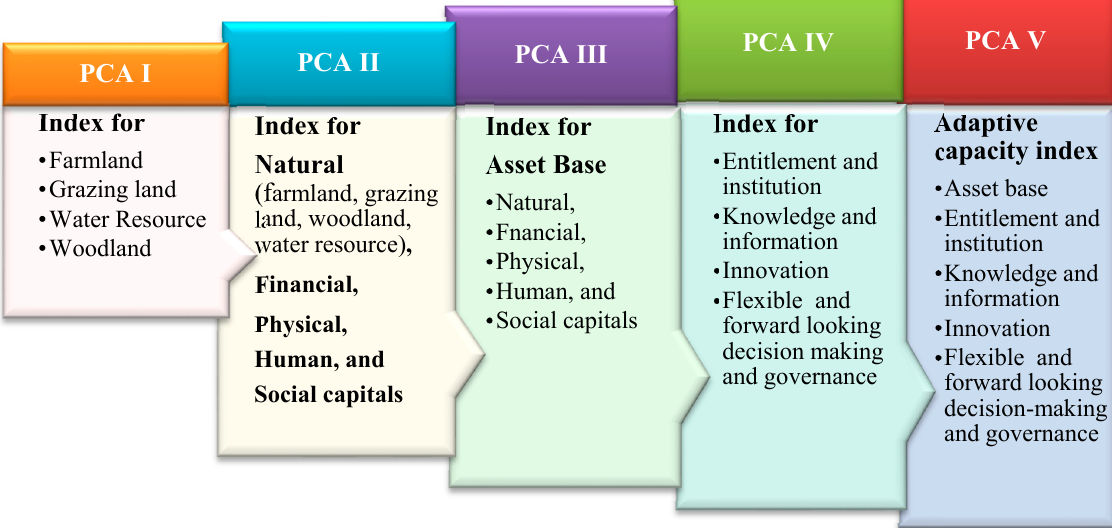
Figure 3. Principal Component Analysis (PCA) steps for generating the index at the household level. Sources: Authors’